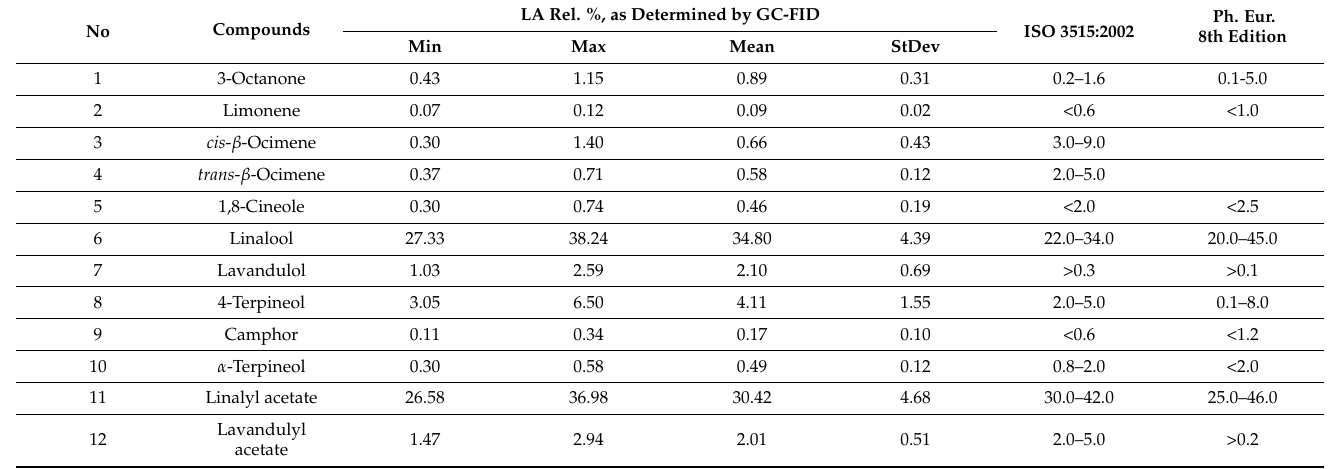
Table 2. The quantitative content variations between the LA